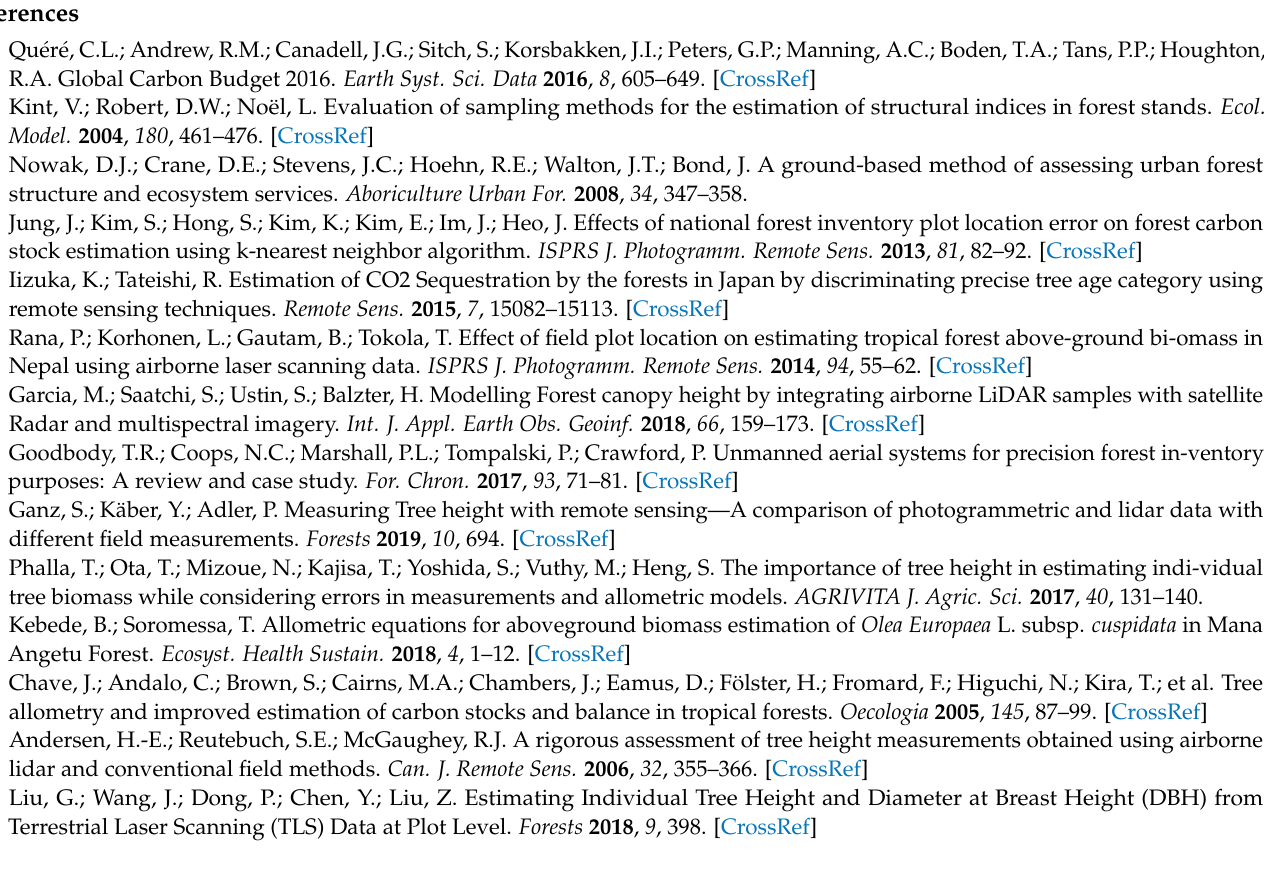
Figure A11. Site-specific relative RSME values of RFR models for AGB estimation in coppice stands.